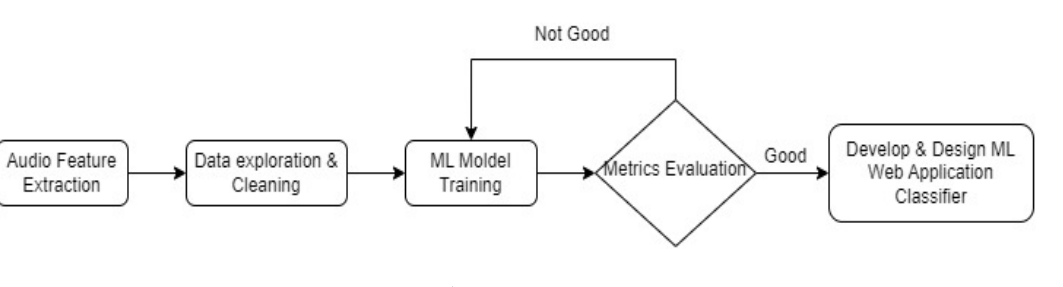
Figure 1. Experiment Pipeline.